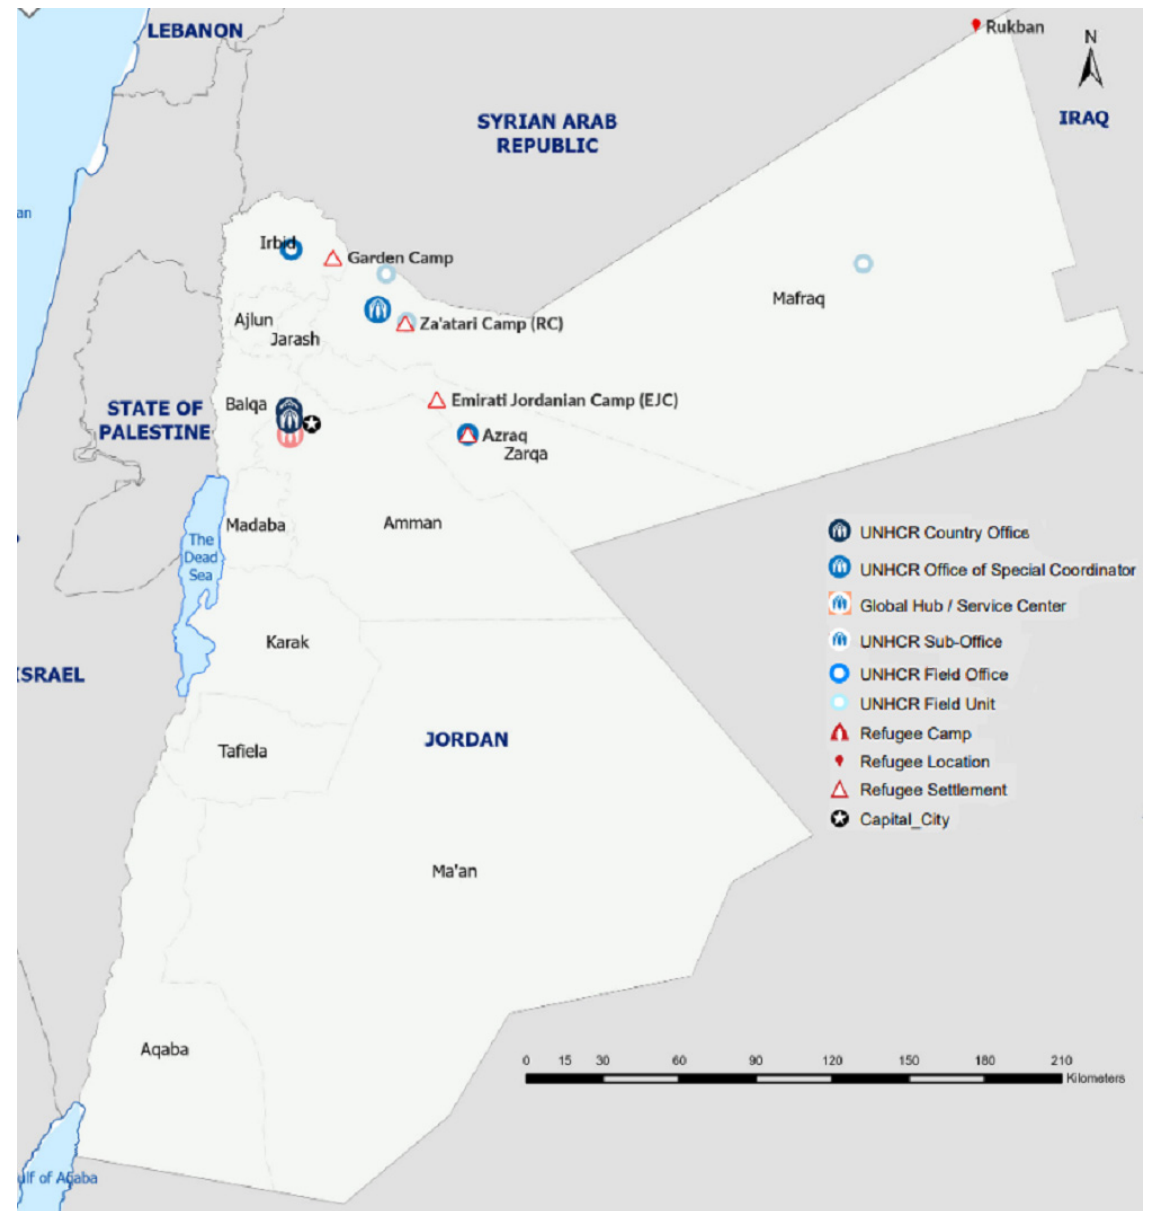
Figure 2. Location of the refugee camps and Ma’an in Jordan [46]